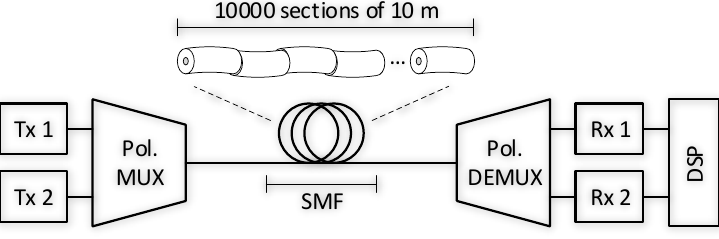
Figure 5. General set-up for numerical simulation model of polarization multiplexed systems.